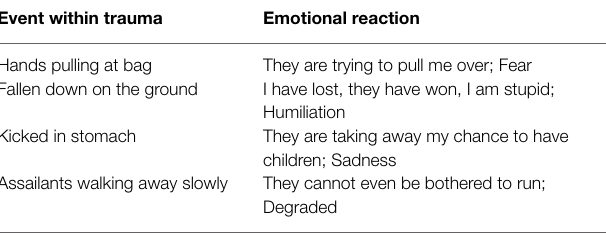
TABLE 1 | Hotspots from one PTSD patient during a mugging